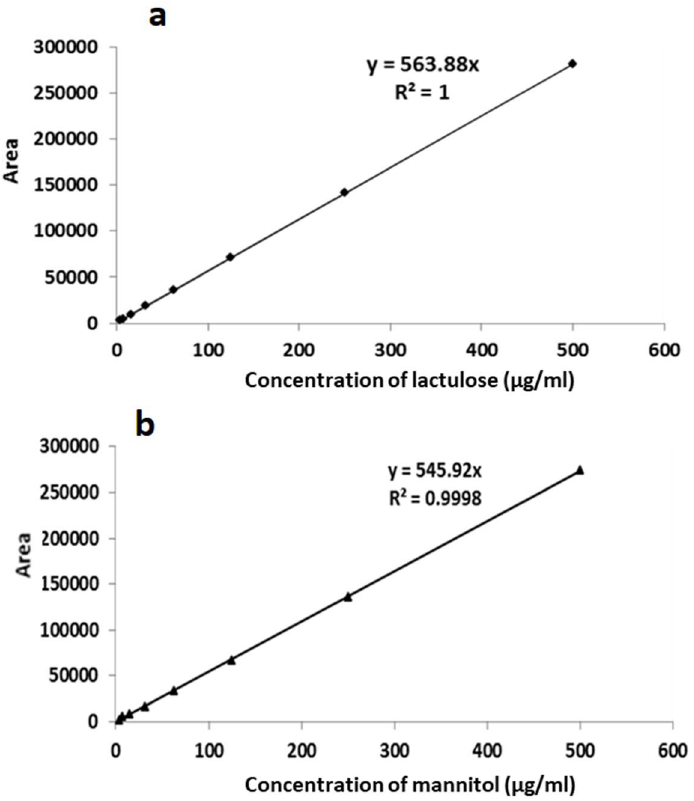
Figure 3. Linear calibration curves from standard solutions for ( a ) lactulose and ( b ) mannitol. The concentration of lactulose and mannitol in each standard was 500 µg mL −1 , 250 µg mL −1 , 125 µg mL −1 , 62.5 µg mL −1 , 31.3 µg mL −1 , 15.6 µg mL −1 , 7.8 µg mL −1 , and 3.9 µg mL −1 , respectively.